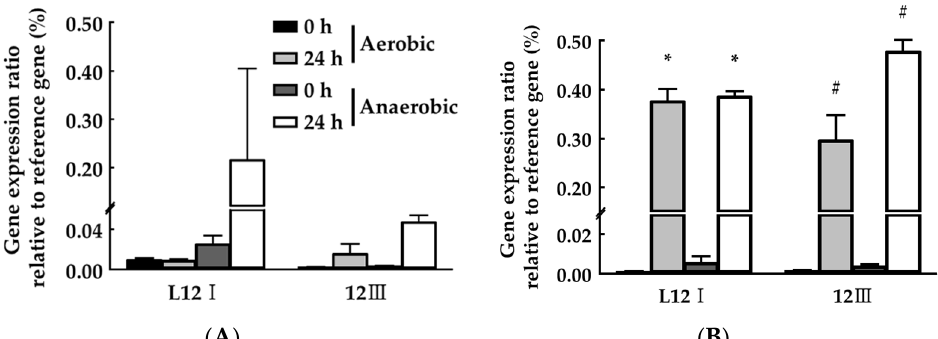
Figure 6. Quantitative real-time PCR analysis to determinate DNA proportion of selected bacterial strains in manure. ( A ) Low-level inoculation (7.98 log CFU), ( B ) high-level inoculation (8.58 log CFU). Values represent the mean ± S.E. ( n = 3). * p < 0.05 (0 vs. 24 h of L12I under the same culture conditions), and # p < 0.05 (0 vs. 24 h of 12III under the same culture conditions) indicates statistical significance.